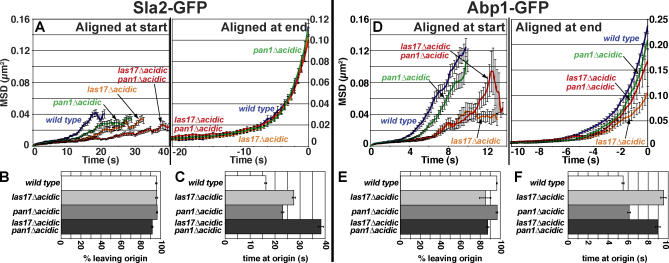
Quantitative Analysis of Actin Patch Motility in Cells Lacking the Arp2/3-Binding Regions of Pan1 and WASp/Las17Cells express Sla2-GFP (A–C) or Abp1-GFP (D–F). (A and D) MSD plots for wild-type and mutant patches aligned at the start (left) or end (right) of their lifetimes. The curves on the left are truncated at the median lifetime. (B and E) Percentage of patches that leave the origin. Mean of values for three segregants is shown. (C and F) Average time at the origin, from the appearance of a patch until it moved away or disappeared.Strain numbers and numbers of patches: (A–C) Wild-type, YJC5707 - 9; 66, 84, and 69. las17Δacidic, YJC5713–5; 100, 95, and 104. pan1Δacidic, YJC5710–2; 103, 76, and 74. las17Δacidic pan1Δacidic, YJC5716–8; 100, 86, and 91. (D–F) Wild-type, YJC5719–22; 99, 100, 114, and 98. las17Δacidic, YJC5726, 8 & 9; 95, 88, and 84. pan1Δacidic, YJC5723–5; 102, 94, and 139. las17Δacidic pan1Δacidic, YJC5730–3; 77, 70, 50, and 50. Error bars are ± standard error.